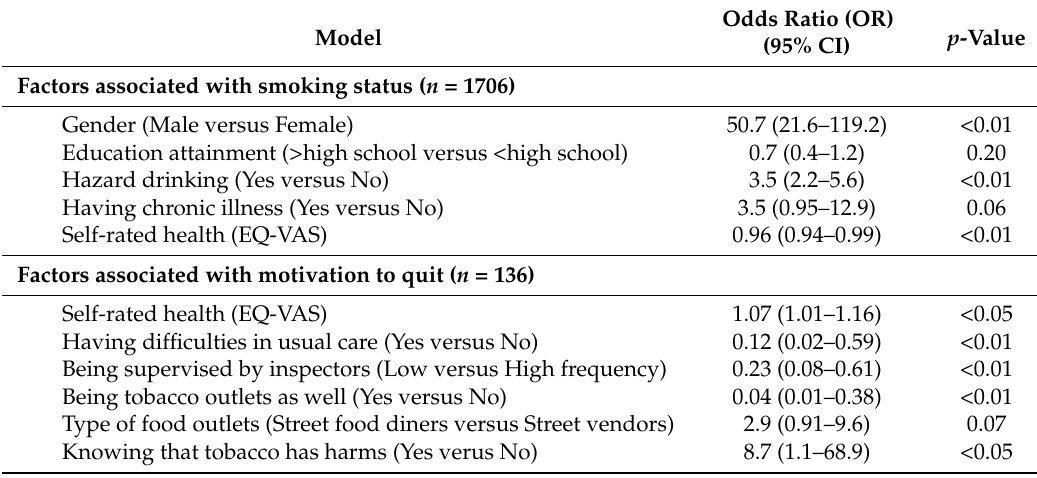
Table 3. Factors associated with current smoking status and motivation to